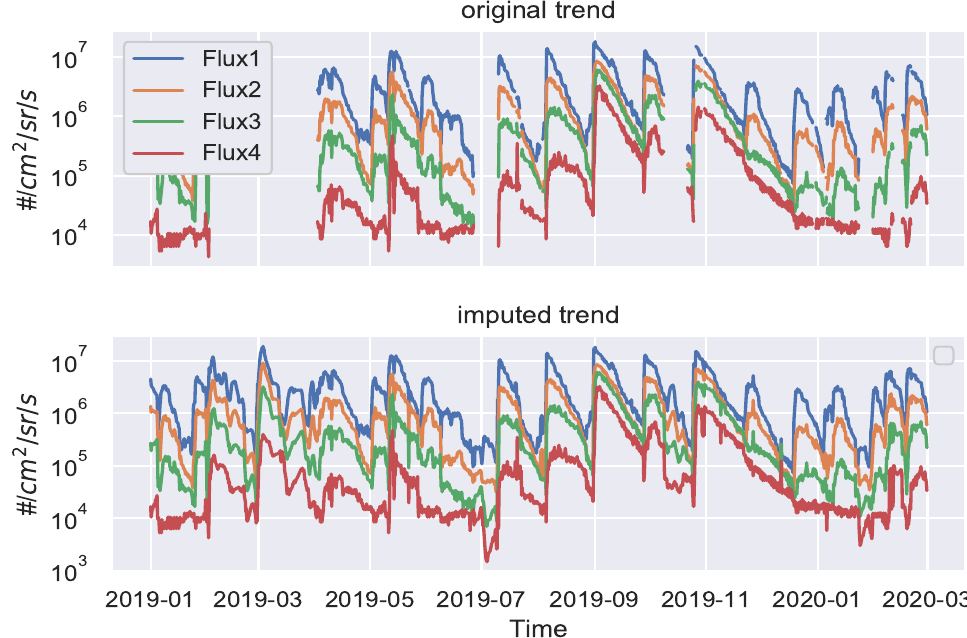
Figure 8. Top panel: Trend of original Beidou MEO data (contain lots of missing data); Bottom panel: Trend of imputed data (the missing data have been